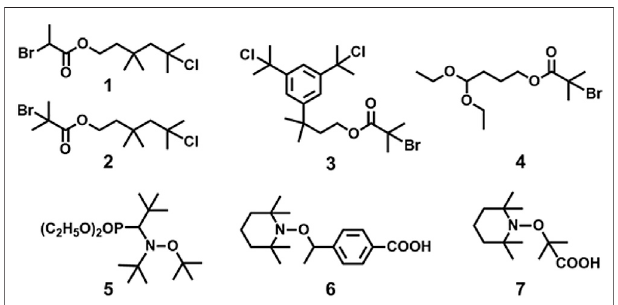
FIGURE 4 | Examples of dual initiators used in combined living cationic polymerization and controlled/living radical polymerization.